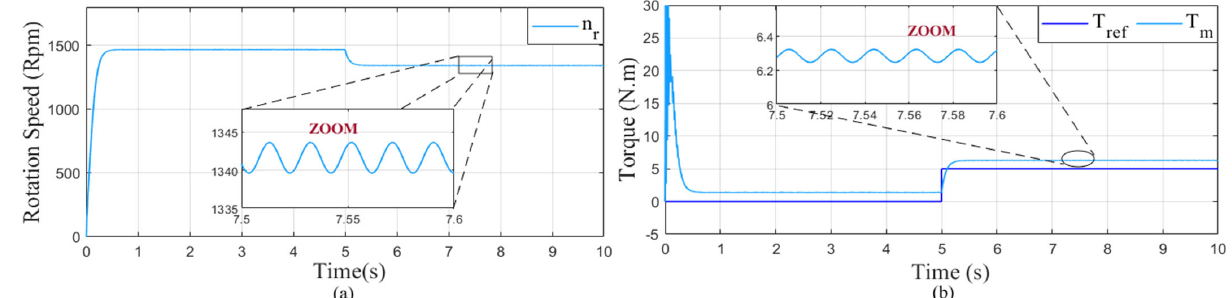
Figure 17. Performance with Ball bearing defect of IM without control: ( a ) rotation speed and ( b ) motor torque.